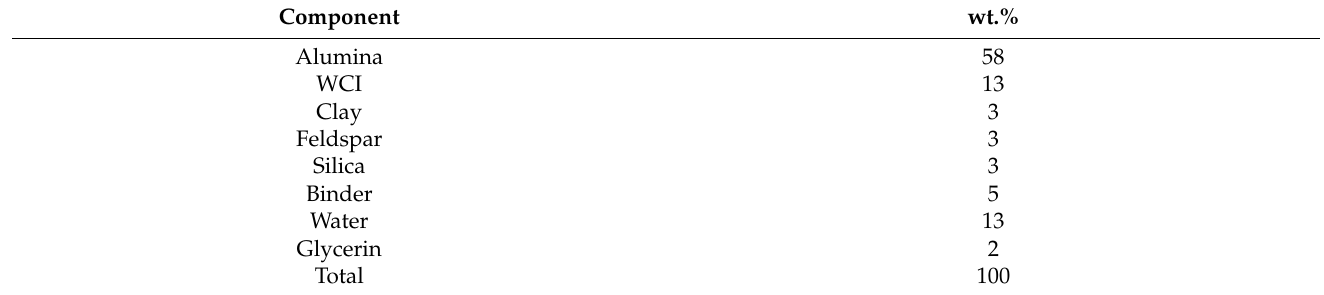
Table 1. Composition of the